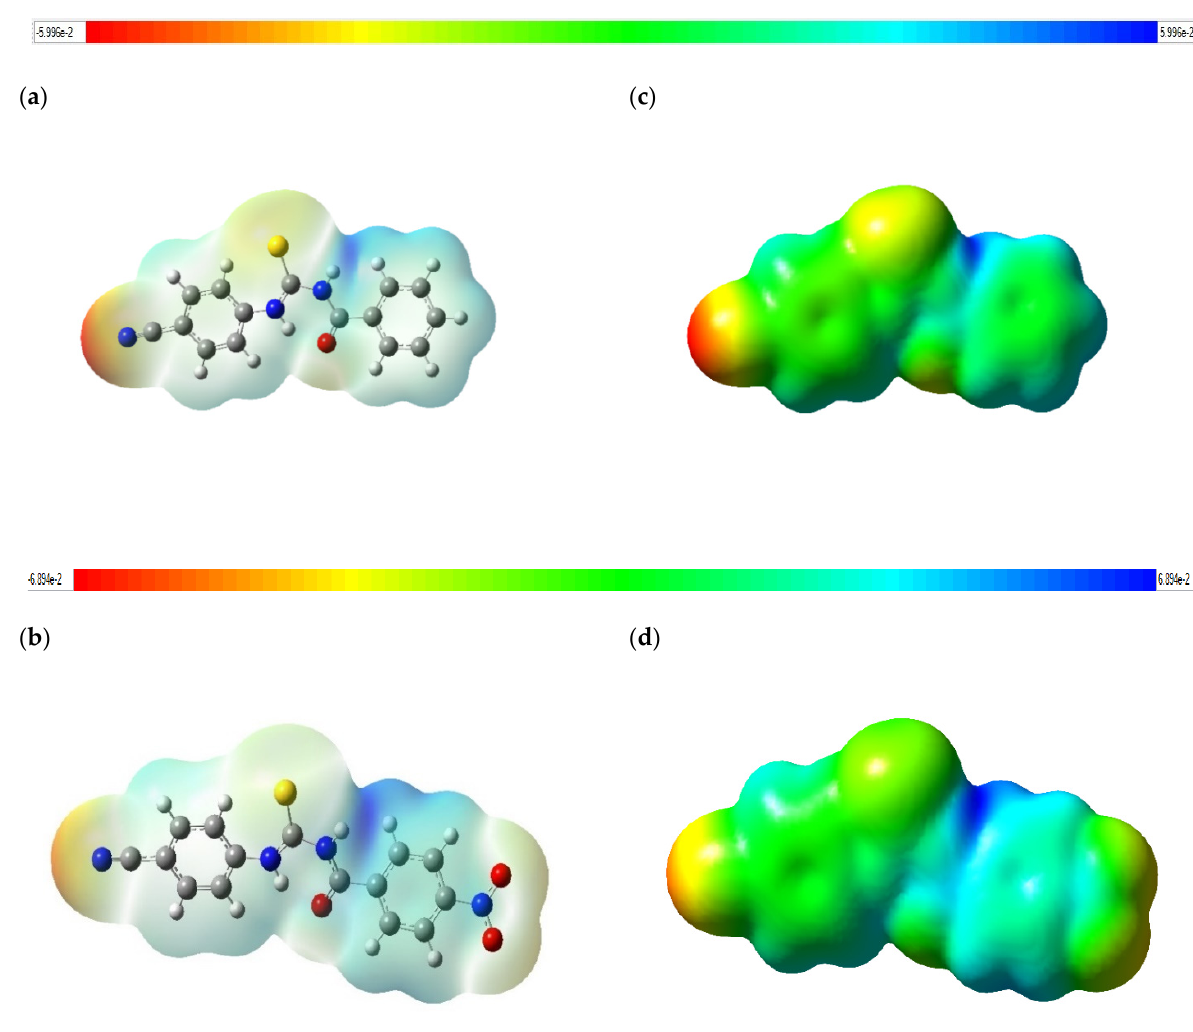
Figure 4. Molecular electrostatic potential map calculated at B3LYP/6-311G(d,p) level for the title compounds 1 ( a , c ) and 2 ( b , d ).